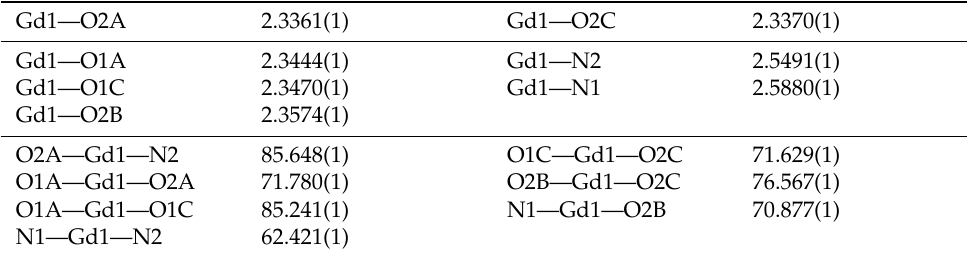
Figure 3. ( a ) molecular structure of [Eu 0.0135 Gd 0.9865 (pta) 3 me-phen], hydrogen atoms omitted for clarity ; ( b ) square–antiprismatic environment around the Ln 3+ ion. Table 2. Selected bond distances (Å) and angles